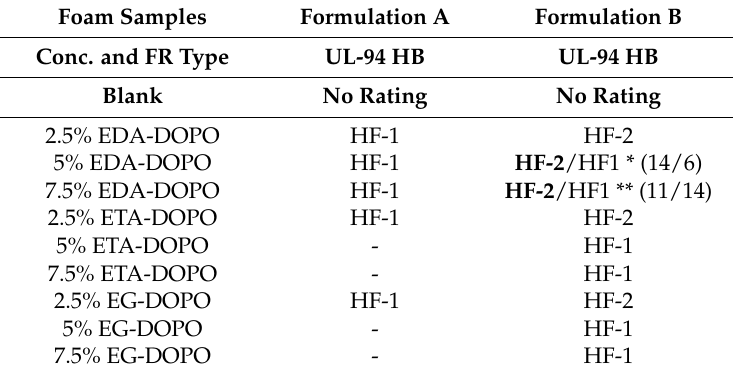
Table 4. UL 94 HB results for foams from formulations A and